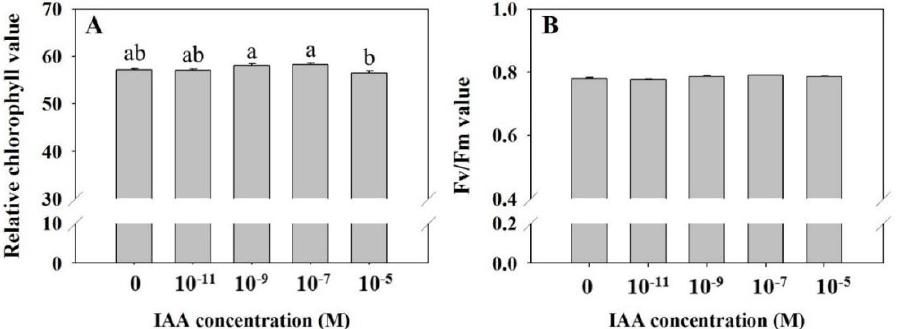
Figure 2. Relative chlorophyll value ( A ) and Fv/Fm value ratio ( B ) of A. rugosa subjected to the control (without IAA) and four IAA treatments. Different letters (a–b) indicate significant differences among treatments at p ≤ 0.05 ( n = 8 and n = 3).